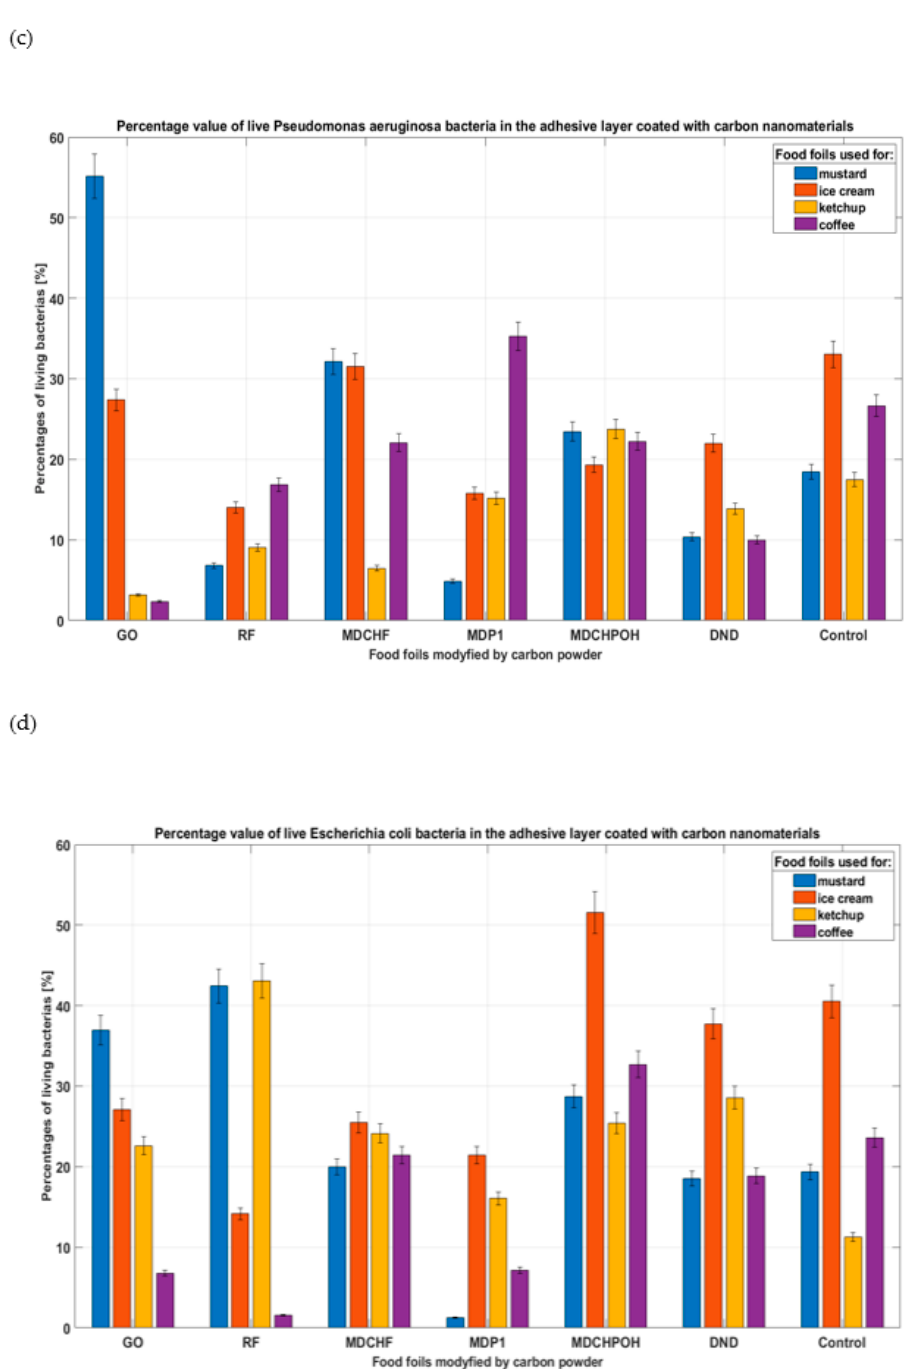
Figure 17. Assessment of the percentage of live bacteria in the adhesive layer. The analysis was carried out in terms of the type of bacteria (Staphylococcus aureus ( a ), Streptococcus mutans ( b ), Pseudomonas aeruginosa ( c ), Escherichia coli ( d )). The bacteria interacted with carbon powders (GO, RF, MDCHF, MDP1, MDCHPOH, DND) on various types of film (I—mustard, II—ice cream, III—ketchup, IV—coffee).